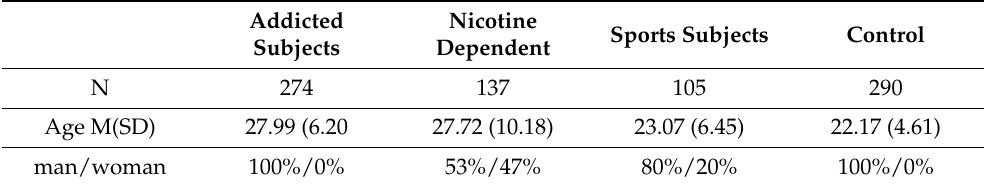
Table 4. Primary statistics include 274 addicted subjects, 137 nicotine-dependent subjects, 105 sports subjects and 290 control